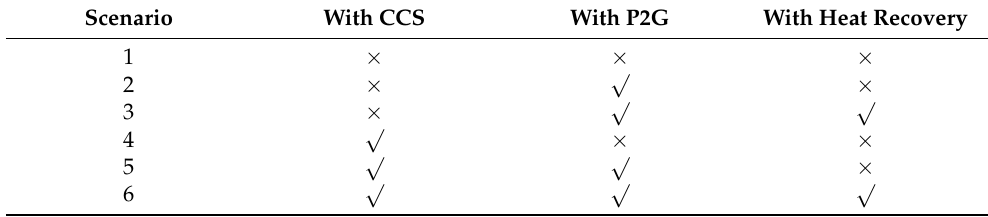
Figure 6. Output power of gas load. Table 2. Module settings of each scenario.